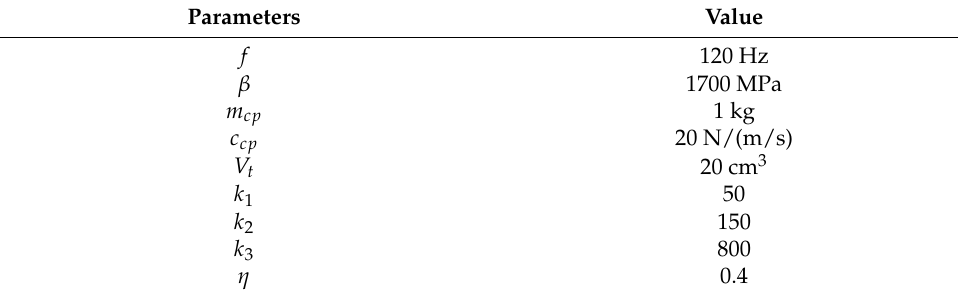
Table 1. Model parameters of the simulation.